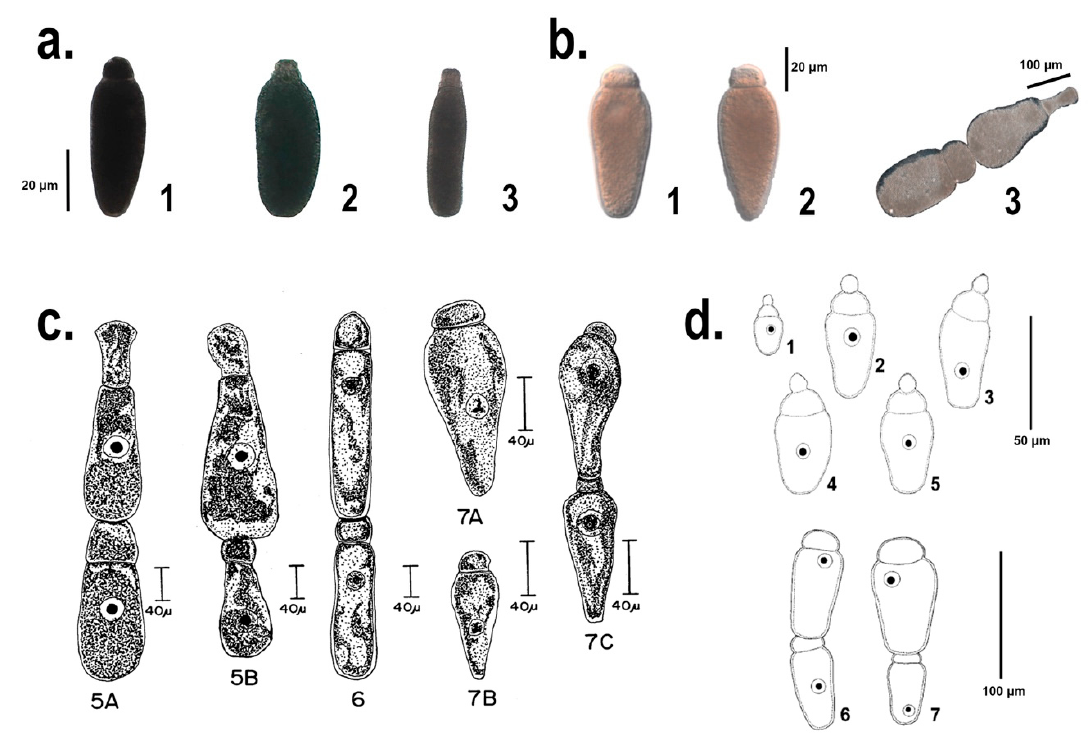
Figure 1. Comparison among the different Gregarina species identified and first described in [32]